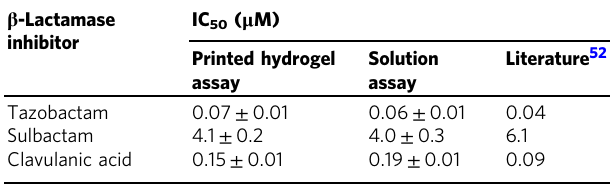
Table 1 Comparison of IC 50 values of classic β -lactamase inhibitors IC 50 values of tazobactam, sulbactam, and clavulanic acid measured by the printed hydrogel assay relative to the conventional solution assay and reported literature